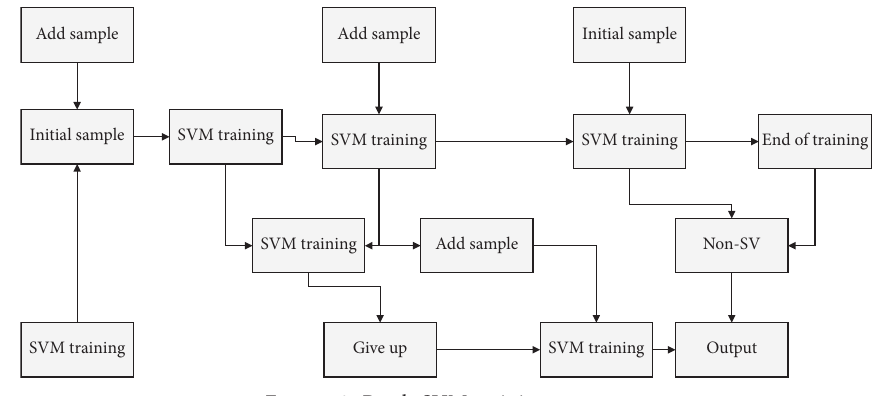
Figure 2: Batch SVM training